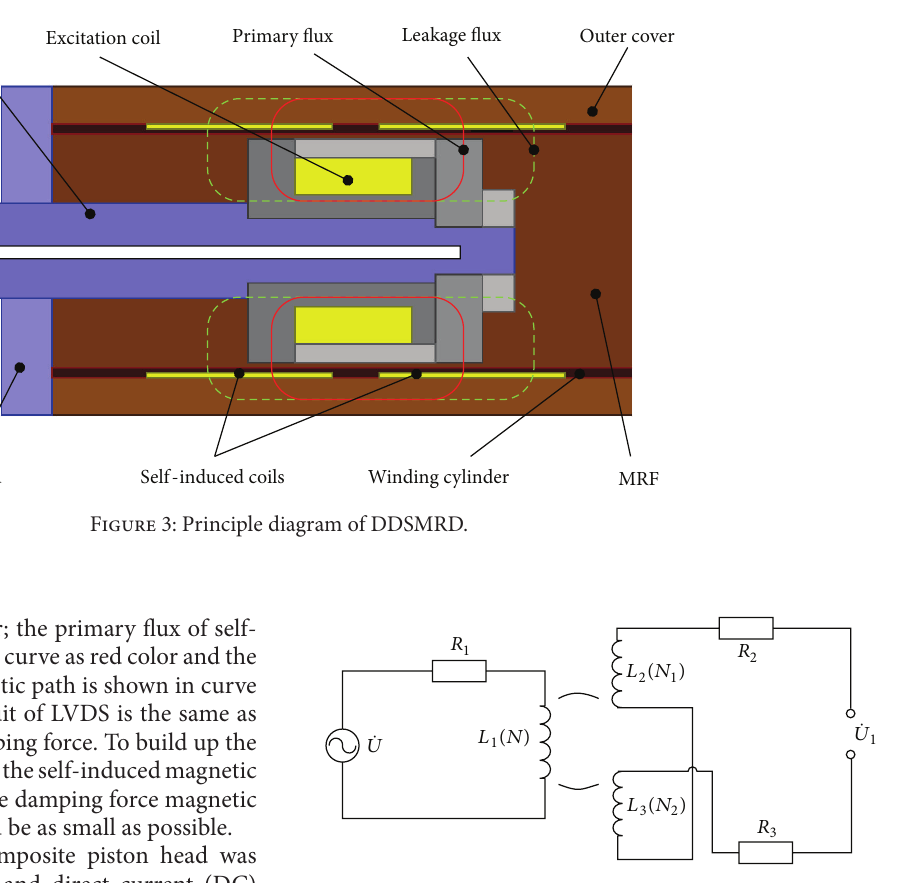
Figure 4: Principle of differential self-induced performance of